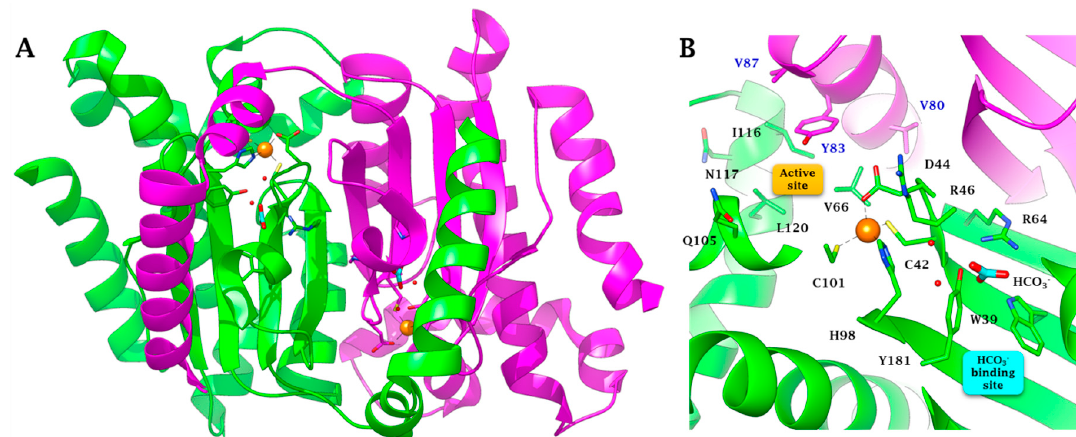
Figure 3. β -CA (CynT2, PDB 2ESF) from E. coli . ( A ) Ribbon representation of the dimer. ( B ) Zoomed view of the active site and bicarbonate binding pocket. The Zn(II) ion is represented as an orange sphere. Chain A and chain B are colored green and magenta, respectively. The HCO 3 − ion is colored cyan. Amino acids composing the active site are labeled with one letter symbols (blue for chain A and black for chain B): A, Ala; C, Cys; D, Asp; H, His; I, Ile; L, Leu; N, Asn; Q, Gln; R, Arg; V, Val; W, Trp; Y, Tyr. The cyan box is the HCO 3 − pocket, while the yellow box represents the catalytic pocket.